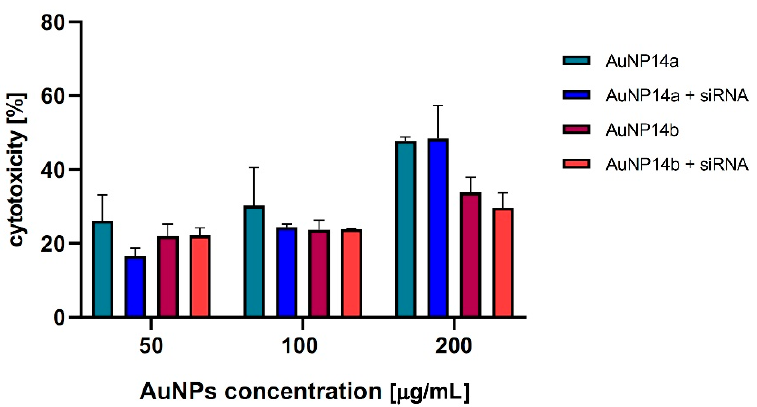
Figure 6. Cytotoxicity effect of AuNPs alone and complexes with siRNA toward HBEC-5i cells, LDH assay. The nanoparticles concentrations varied from 50 to 200 µg/mL. All results were compared to positive control with Triton X-100: incubation time, 24 h. Data points represent means ± SD obtained from min. 3 separate experiments.